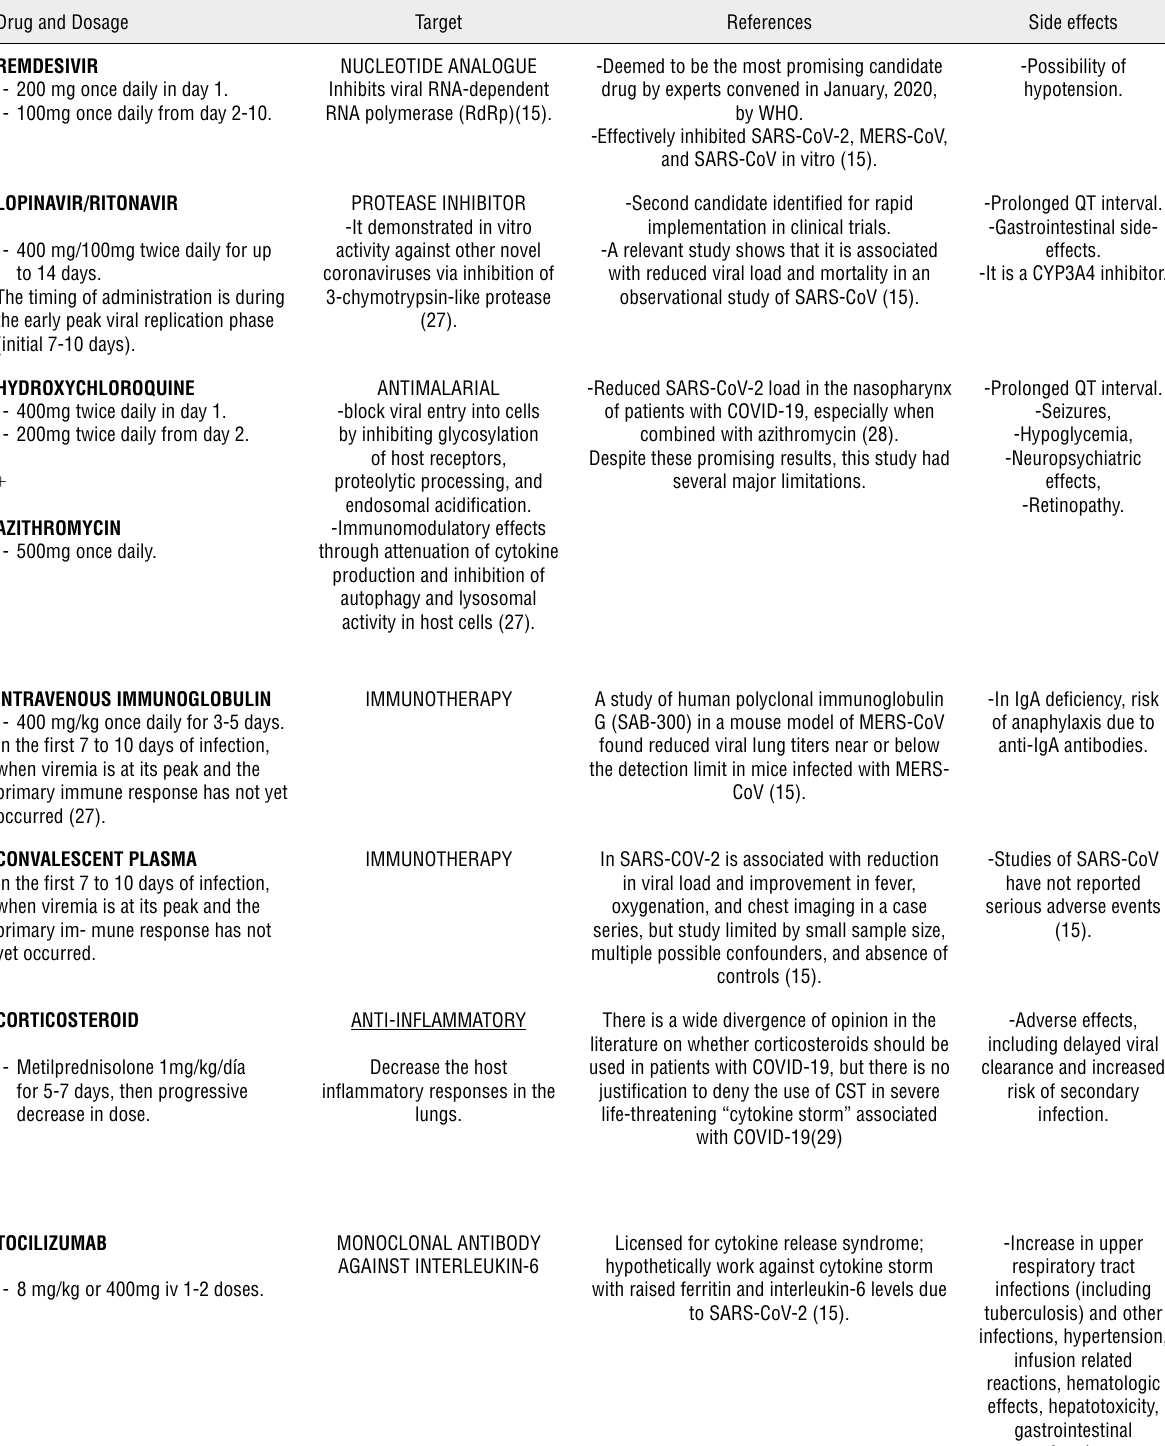
Table 7 - Drugs most commonly used as